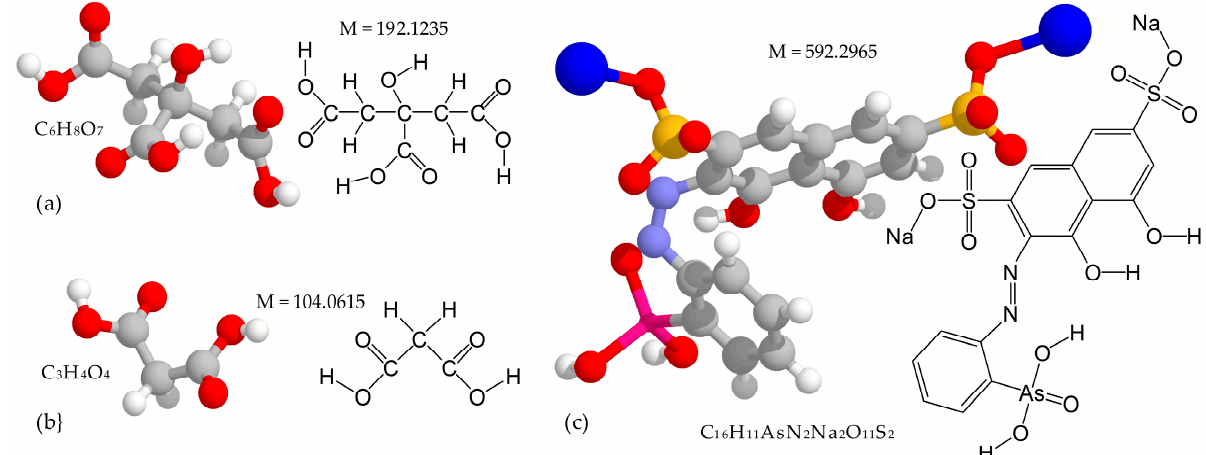
Figure 1. Chemical structure of ( a ) citric and ( b ) malonic acids and ( c ) arsenazo-I. Arsenazo-I additive concentration in solution C Ars was calculated using the formula